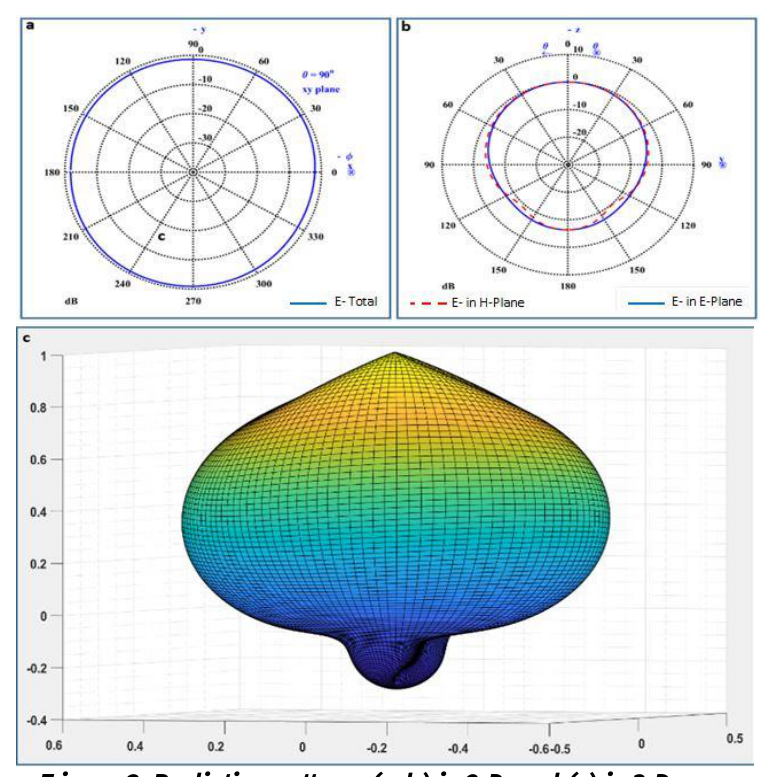
Figure 6: Radiation pattern: (a, b) in 2-D and (c) in 3-D